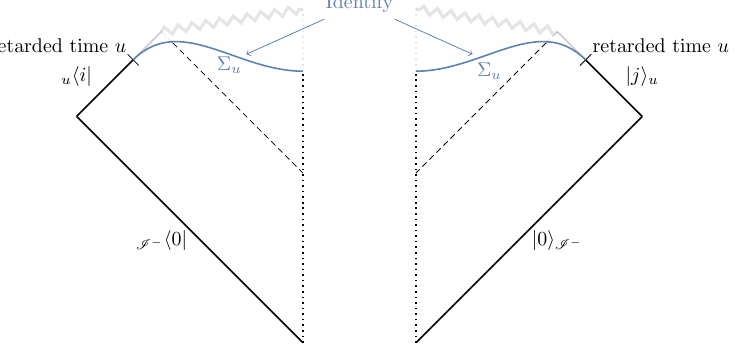
Figure 6. The path integral on this geometry computes matrix elements u h j | ρ u | i i u of the density matrix ρ u describing Hawking radiation in the piece I u of I + before retarded time u . Two copies of the original black hole spacetime have been glued together along a surface Σ u , which defines a Cauchy surface when joined to I u . We impose boundary conditions on I u corresponding to the states | i i u , | j i u .